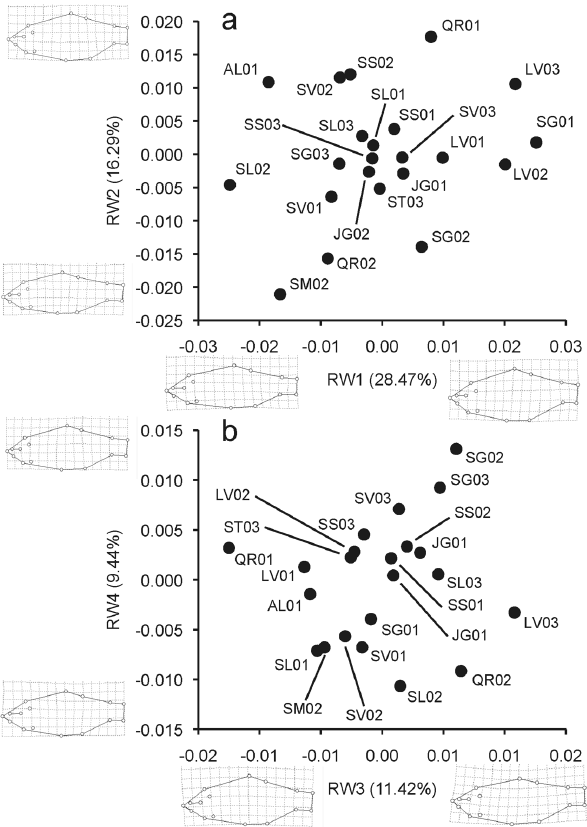
Fig. 3. Relative warps (RW) of body shapes among 22 po- pulations of Bryconamericus iheringii : Alegrete (AL), Ja- guarão (JG), Santo Antônio das Missões (SM), São Gabriel (SG), Santiago (ST), São Pedro do Sul (SS), Soledade (SL), Quaraí (QR), Santana da Boa Vista (SV) and Lavras do Sul (LV). Warp transformation grids depict the body shapes as- sociated with the extremes of each